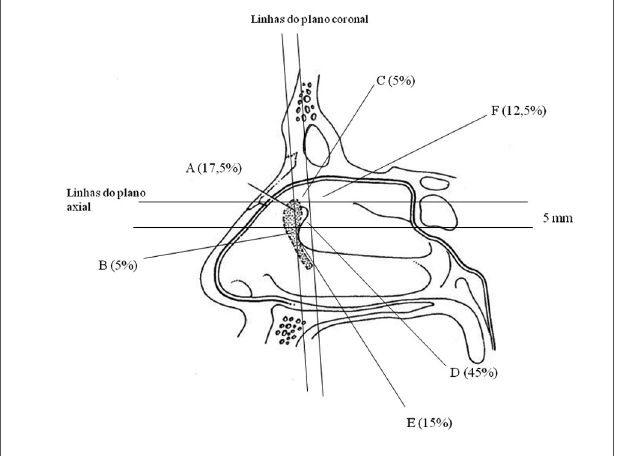
Figura 4. Representação esquemática dos locais onde o ponto de transiluminação foi encontrado e suas respectivas frequências. A. Anterior à cabeça do corneto médio x imediatamente abaixo da inserção do corneto médio. B. Anterior à cabeça do corneto médio x abaixo da inserção do cor- neto médio. C. Posterior à cabeça do corneto médio e anterior à inserção do corneto médio x acima da inserção do corneto médio. D. Posterior à cabeça do corneto médio e anterior à inserção do cor- neto médio x imediatamente abaixo da inserção do corneto médio. E. Posterior à cabeça do corneto médio e anterior à inserção do corneto médio x abaixo da inserção do corneto médio. F. Posterior à inserção do corneto médio x acima da inserção do corneto